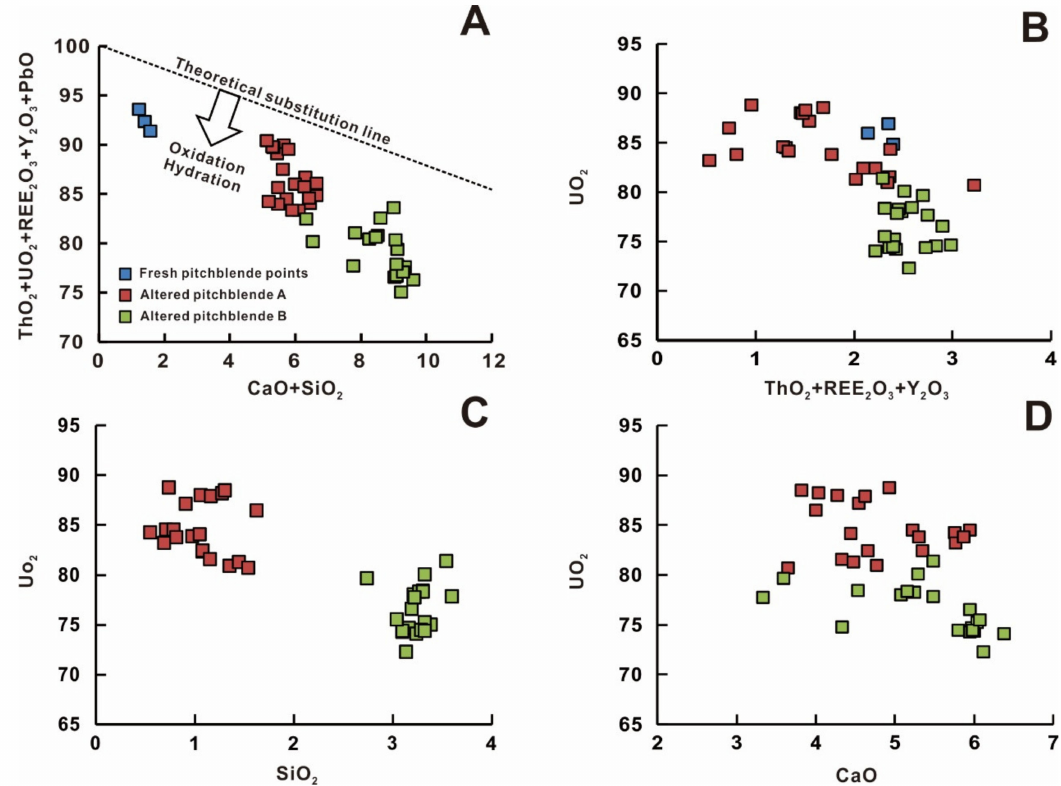
Figure 8. Binary diagrams for di ff erent major and minor elements in pitchblende (in weight percent). ( A ) ThO 2 + UO 2 + REE 2 O 3 + Y 2 O 3 + PbO vs. CaO + SiO 2 shows the pitchblende was subjected to hydrothermal alteration with CaO and SiO 2 enrichment. ( B ) UO 2 vs. ThO 2 + REE 2 O 3 + Y 2 O 3 shows that ThO 2 + REE 2 O 3 + Y 2 O 3 contents did not change significantly during the alteration. ( C ) UO 2 vs. SiO 2 shows that there is a compositional gap between altered pitchblendes A and B. ( D ) UO 2 vs. CaO shows that altered pitchblendes A and B have the same range content of CaO, and altered pitchblende A has higher UO 2 contents than